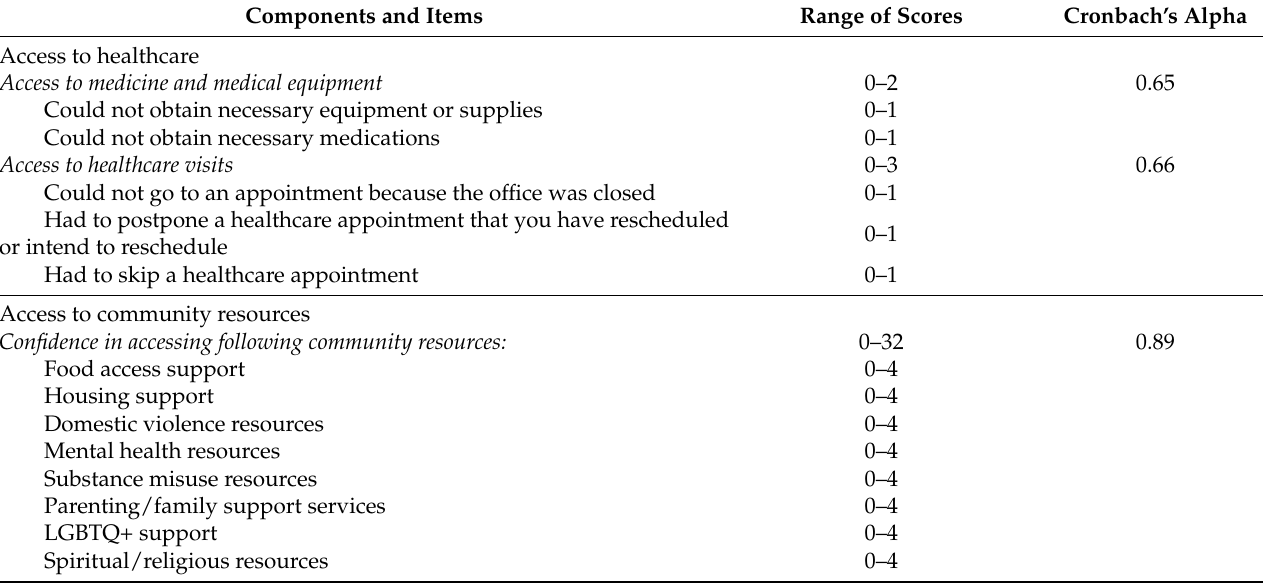
Table 2. Components of access-to-health-services